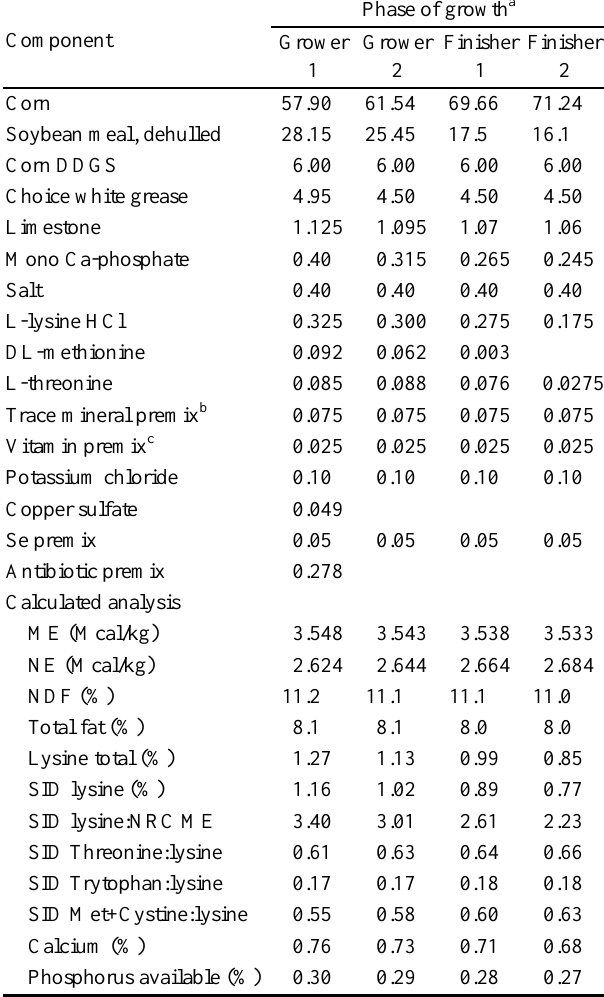
Table 2. Diet composition (%) specifications for the high energy